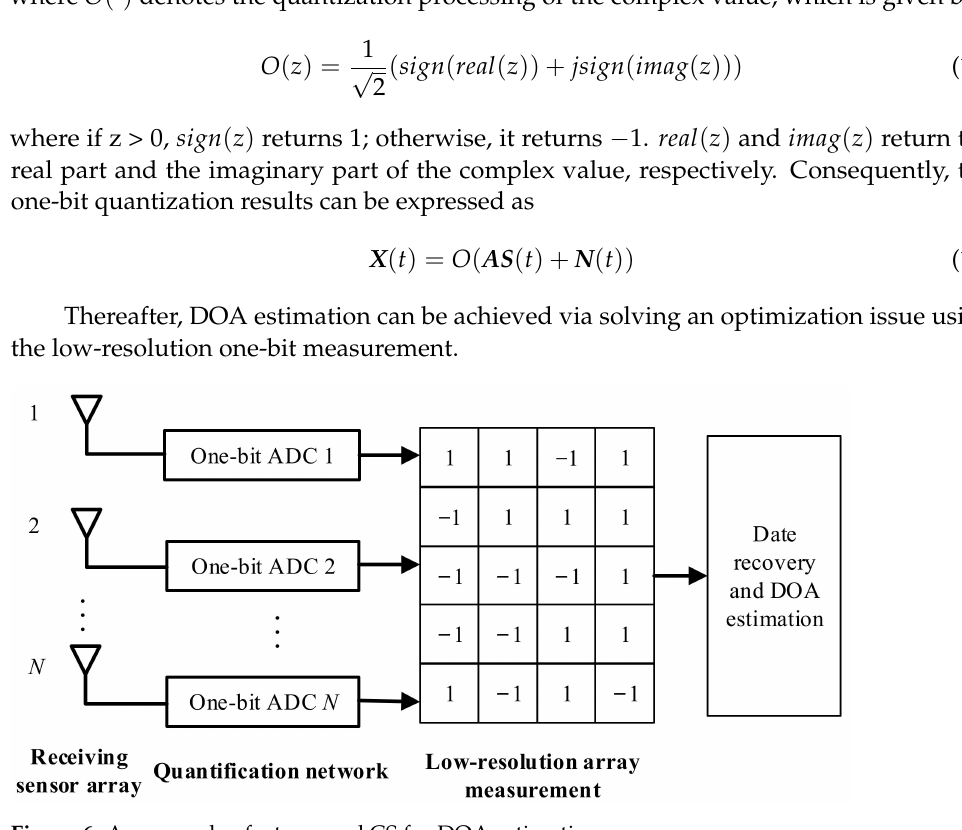
Figure 6. An example of a temporal CS for DOA